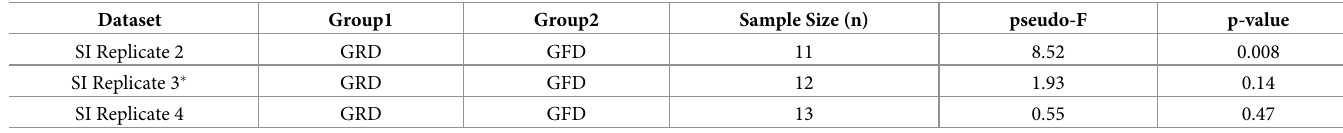
Fig 5. Dietary gluten may increase peptidase activity in the SI, which is positively correlated with SI enteropathy. (A) PcoA plots arranged by replicate experiment (based on Bray-Curtis analysis). PERMANOVA. (B) Differentially abundant inferred microbial genes are shown between GRD and GFD-fed J H-/- mice. (C) Correlation analysis between the abundance of three microbial peptidase enzymes and SI enteropathy in GRD- fed mice are shown. One-way ANOVAs were used to analyze “gene x disease” correlations. https://doi.org/10.1371/journal.pone.0264977.g005 Table 2. PICRUSt PERMANOVA results of β -diversity analyses